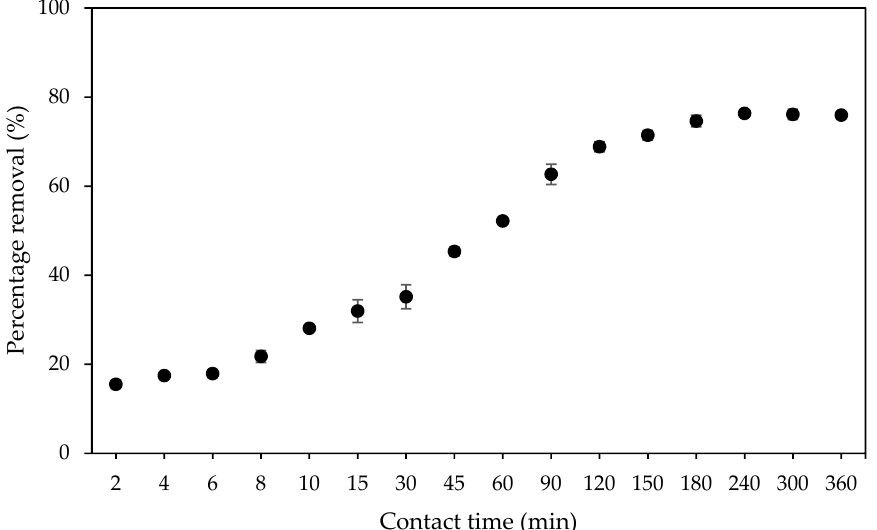
Figure10. E ff ectofcontacttimeonthepercentageremovalofPb(II)ions. Condition: [Pb(II)] = 100 mg / L, dosage of adsorbent = 40 mg, pH = Figure 10. Effect of contact time on the percentage removal of Pb(II) ions. Condition: [Pb(II)] = 100 mg/L, dosage of adsorbent = 40 mg, pH = 5.